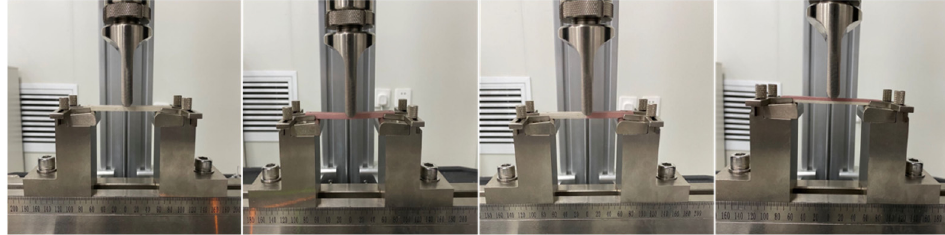
Figure 5. Mechanical testing using an MTS testing machine.